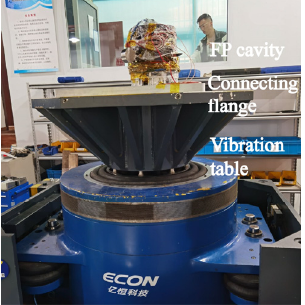
Figure 4. Whole system (WS) during vibration tests. (The non-English term in the upper left corner of the figure is the safety instructions. Whereas, that in the bottom of the figure is the company’s name in